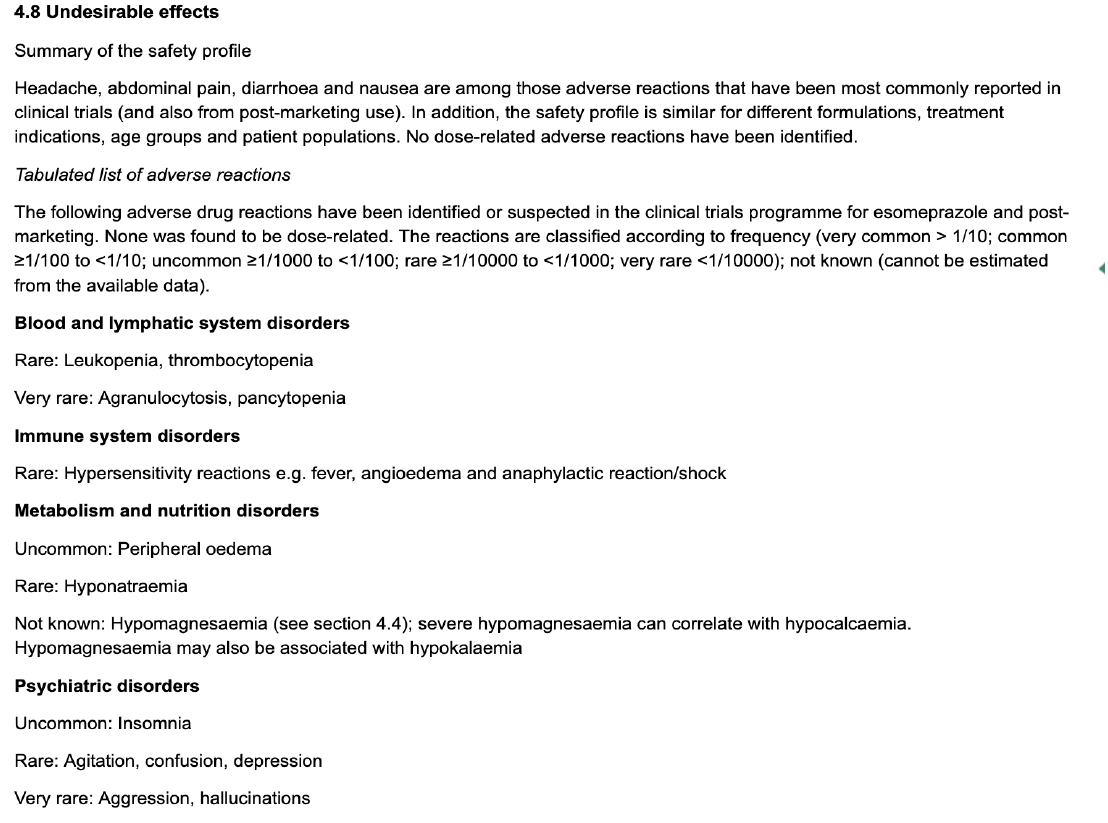
Figure 2. An example of a Summary of Product Characteristics (SmPC) excerpt.